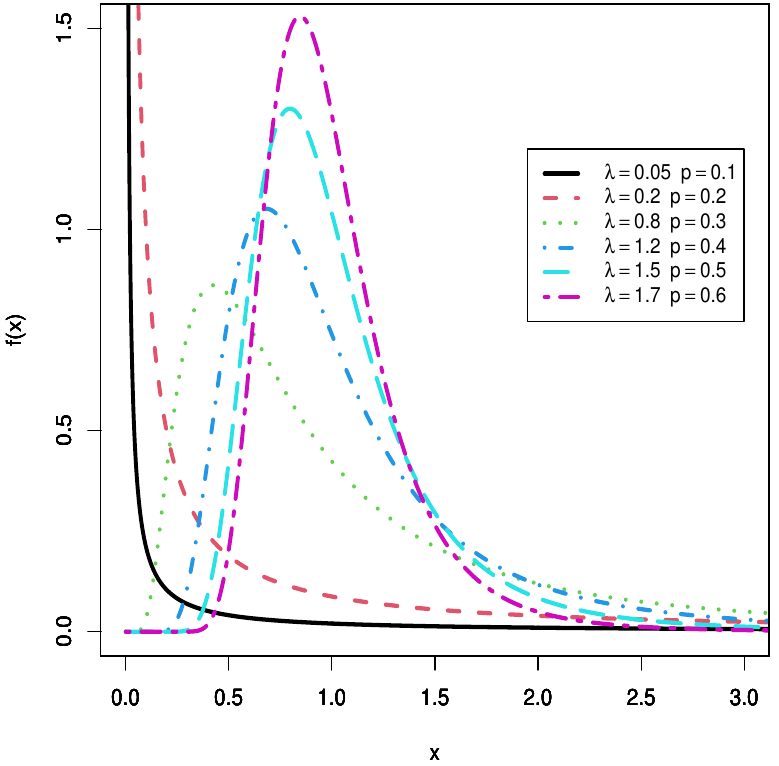
Figure 2. Different shapes of pdf for FB distribution at β = 1.5 and n =